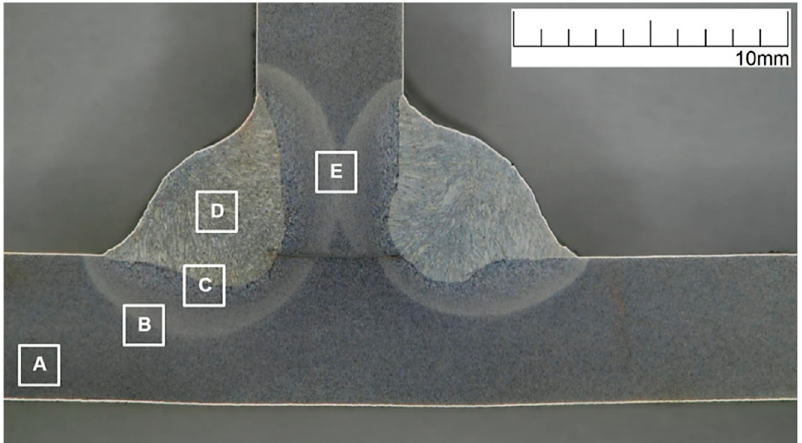
Figure 13. Macrostructure of the test joint with marked areas of the microstructure test: A—parent material, B—heat-affected zone (HAZ), C—weld and heat-affected zone boundary, D—weld, and E—heat-affected zone (HAZ).